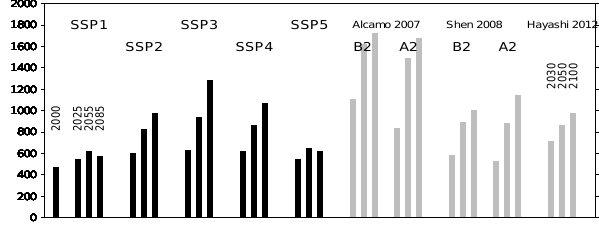
Fig. 12. Scenarios of total global withdrawal-based potential mu- nicipal water demand (km 3 yr − 1 )